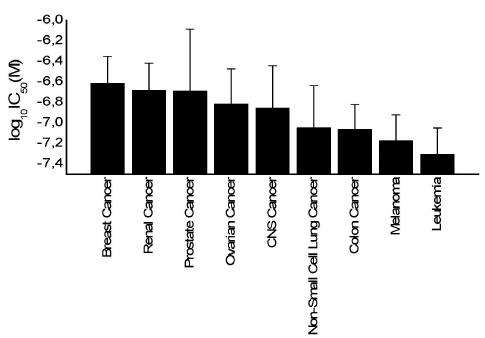
Figure 4. Mean values and standard deviations of log 10 IC 50 values for secalonic acid of the NCI cell lines of di ff erent tumor